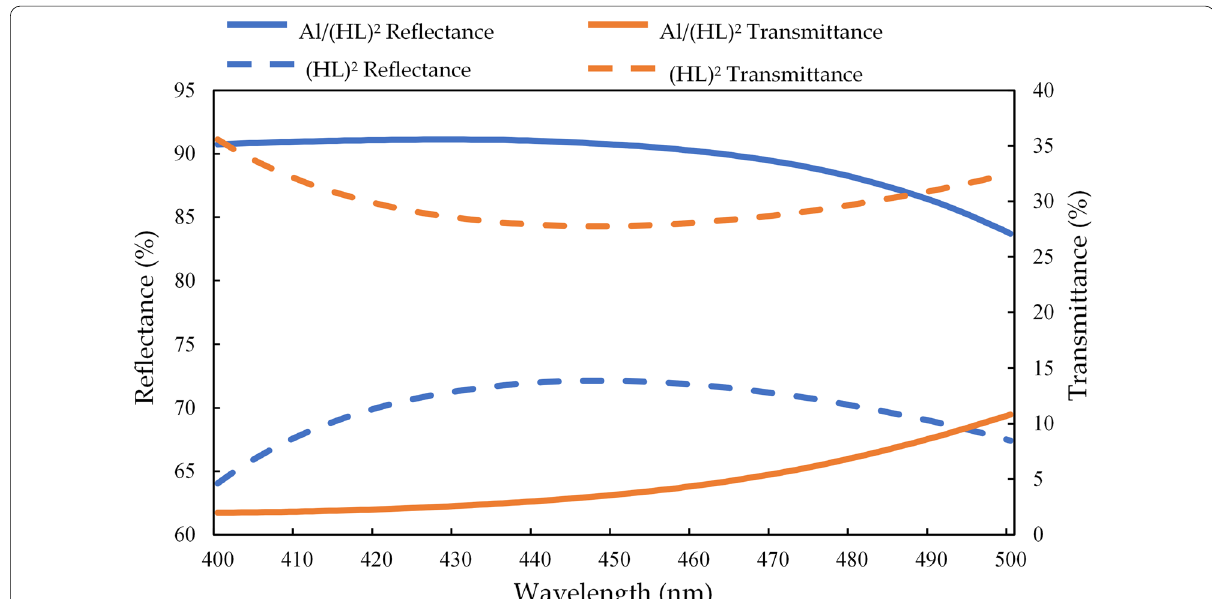
Fig. 4 Reflectance and transmittance ratios of the simulated thin‑film structures of Al/(HL) 2 and (HL) 2 for wavelengths in the range of 400–500